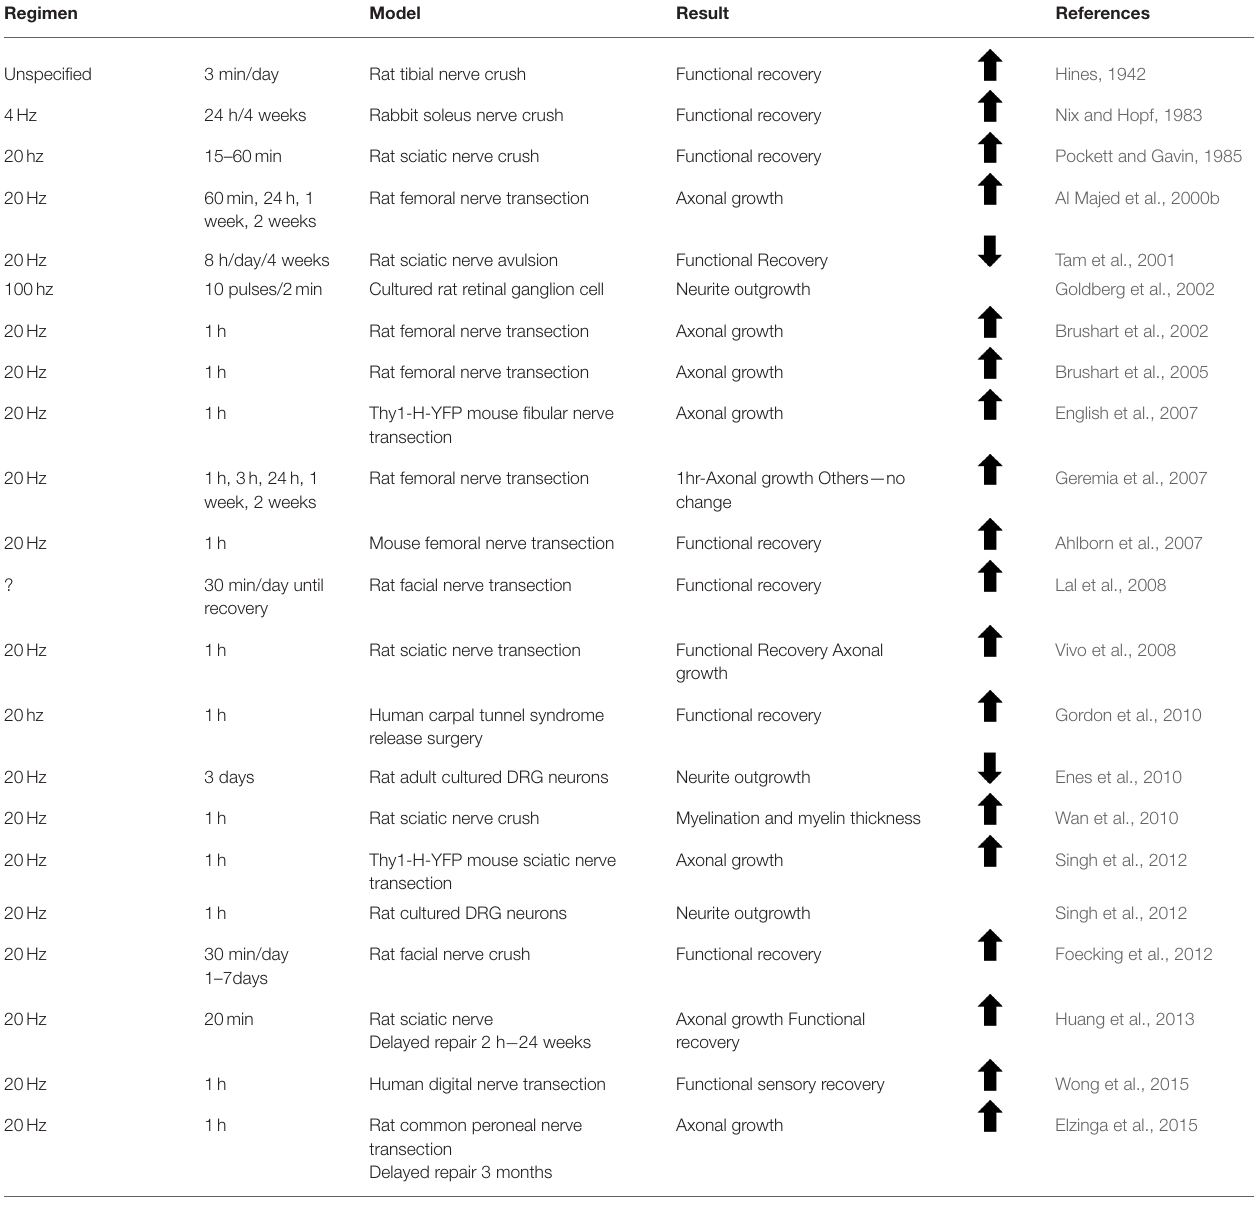
TABLE 1 | Effect of electrical stimulation on peripheral nerve regeneration.